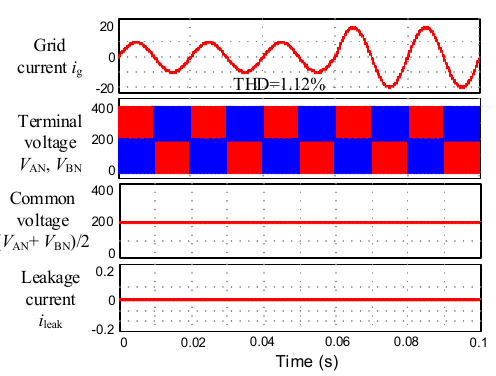
Figure 30. Waveforms of grid current, terminal voltage, CM voltage, and leakage current in the case.